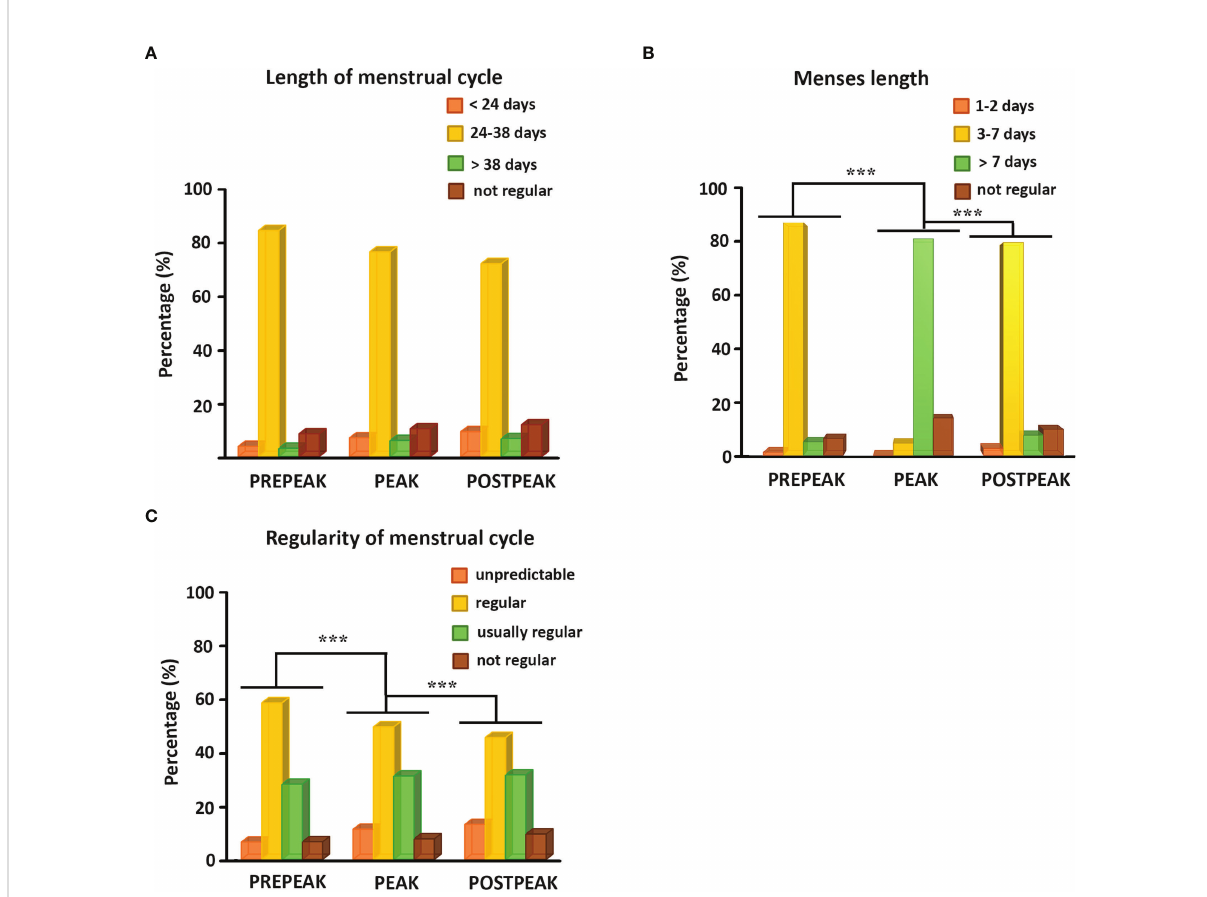
FIGURE 4 (A) Histograms show the percentage of female individuals bleeding more frequently than 24 days, between 24 and 38 days, less frequently than 38 days and having no regular menstrual bleeding during the pre-peak, the peak, and the post-peak period. (B) Histograms illustrate the percentage of female participants with menses length lasting for 1-2 days, 3-7 days, more than 7 days or having no regular bleeding during the pre-peak, the peak, and the post-peak period. (C) Histograms demonstrate the percentage of female respondents with unpredictable cycle, having regular cycle with a maximum delay of 1-2 days, usually regular cycle with 1-2 missed cycles or 1-2 weeks difference a year, or not regular menstrual cycle during the pre-peak, the peak, and the post-peak period. ***p ≤